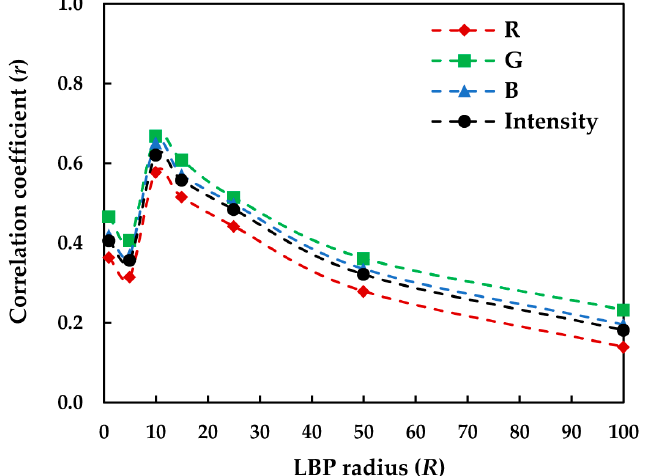
Figure 15. The correlation between the VRS Cpx of the textiles and rotation-invariant uniform LBP feature of the textile images in the sRGB space depends on the LBP radius R .